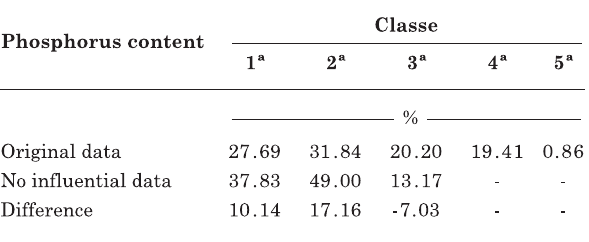
Table 4. Percentage of the area that each class represents in the maps of phosphorus content (mg dm -3